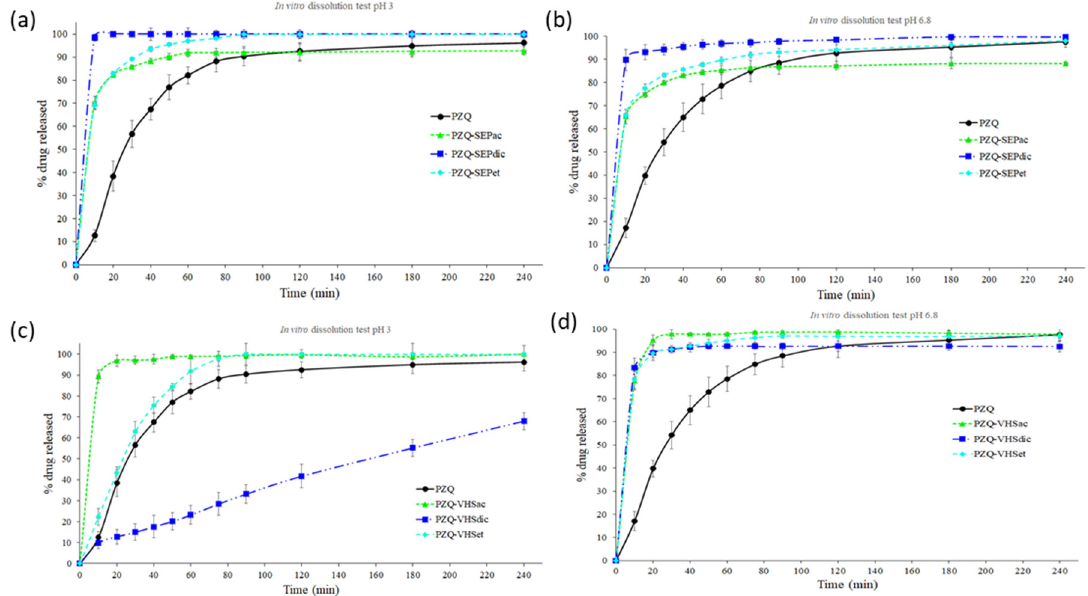
Figure 5. In vitro drug release profiles of sepiolite interaction products in HCl 0.001 M ( a ) and in simulated intestinal fluid ( b ), and of montmorillonite interaction products in HCl 0.001 M ( c ) and in simulated intestinal fluid ( d ); (mean values ± 6 SD; n =